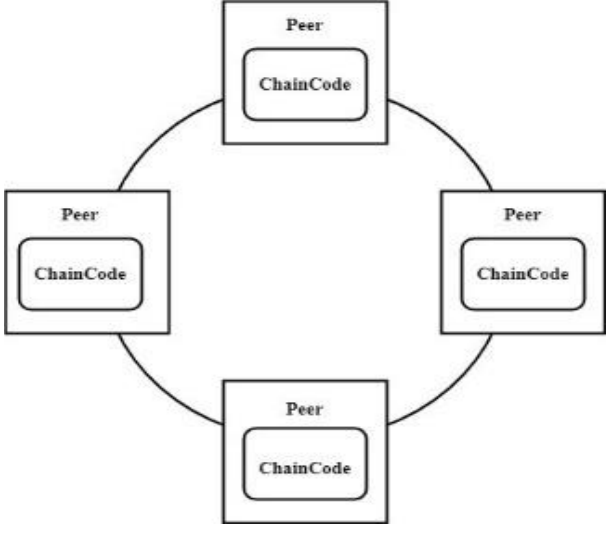
Figure 6. Chaincode architecture. Table 2. Comparison between Ethereum and Hyperledger